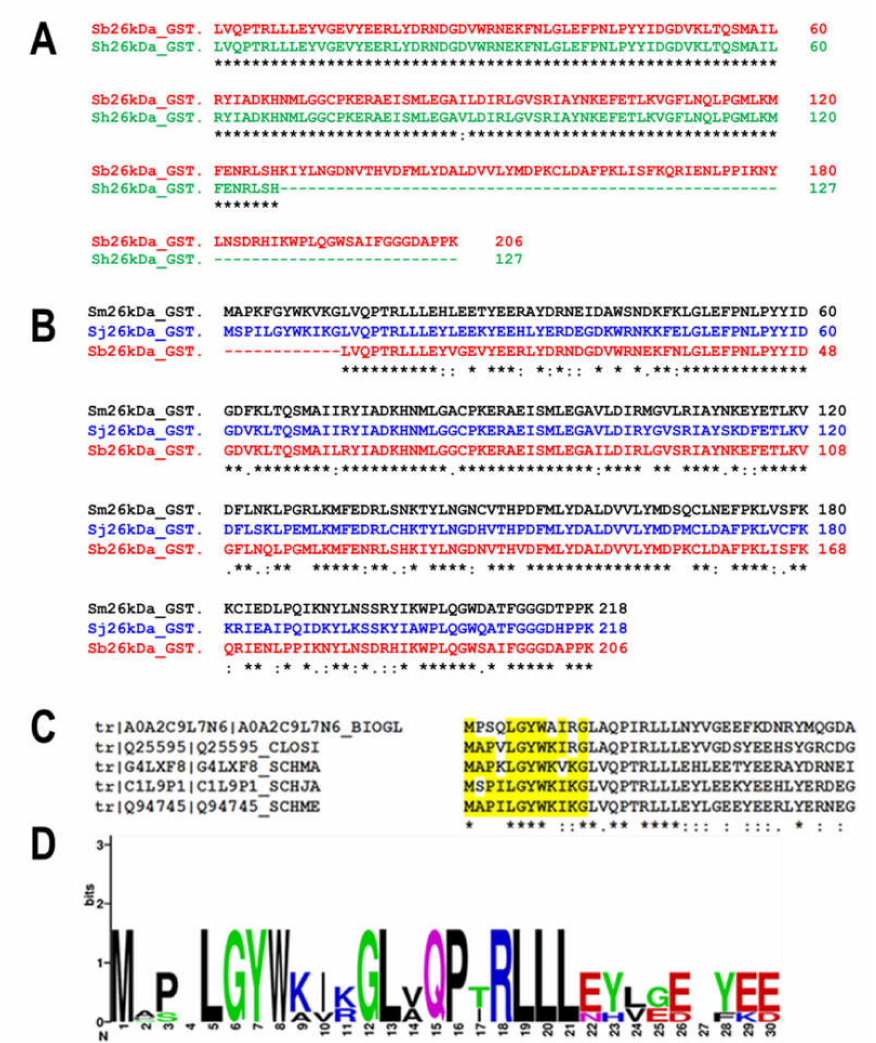
Figure 1. Sequence analysis aiding in the construction of the pseudo- Schistosoma bovis/haematobium 26-kDa GST. ( A ) Alignment of the fragments of the putative 26-kDa GST from S. bovis ( red ) and S. haematobium ( green ) using Clustal Omega. Excluding the additional C-terminus region in bovis , these sequences share 99.9% sequence identity. ( B ) Alignment of the putative 26-kDa S. bovis GST fragment ( red ) with the 26-kDa GST isoforms of S. japonicum ( blue ) and S. mansoni ( black ). This highlights the missing 12 amino acids in the N -terminus, confirming that the fragmented sequence is likely to be the 26-kDa isoform from bovis and/or haematobium . ( C ) Alignment of the identified five top-scoring sequences from BLAST analysis using dendrogram clustering (implemented in the Clustal Omega algorithm). ( D ) WebLogo analysis of the alignment in C indicating the consensus sequence to be MAP A LG Y WKIKG. Alanine is the 4th amino acid, and the catalytic Tyr (in bold ) is the 7th. The UniProt Kb accession numbers for 26-kDa S. bovis , S. haematobium , S. japonicum , and S. mansoni GSTs are A0A430Q9J5, A0A6A5D1Y9, P08515, and P15964,